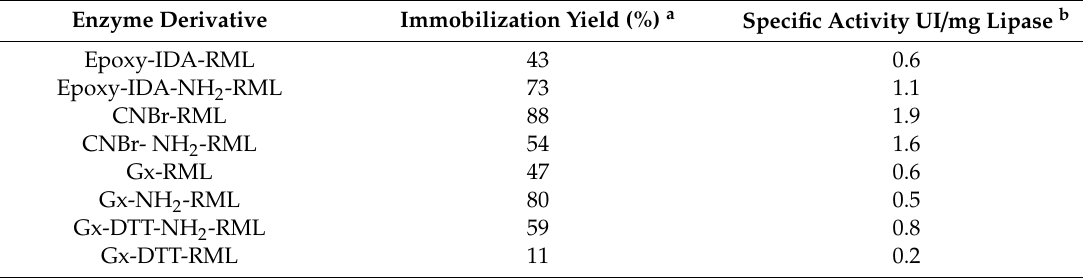
Table 1. Parameters of di ff erent RML